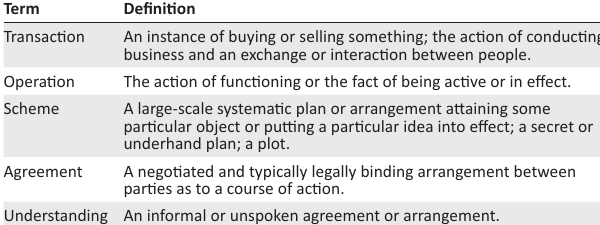
TABLE 1: Dictionary definitions of